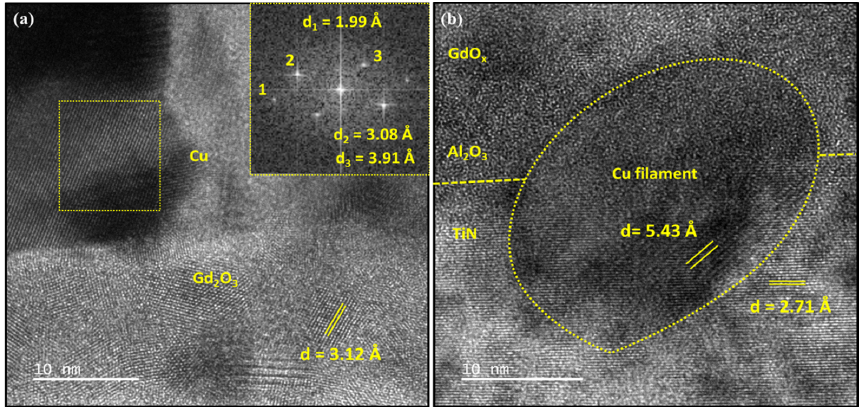
Figure 6. HRTEM images of the S2 devices after SET. ( a ) Cu TE/GdO x interface without Cu filament and ( b ) with Cu filament region. Inset of ( a ) shows the FFT image of Cu, and corresponding d-spacing values.